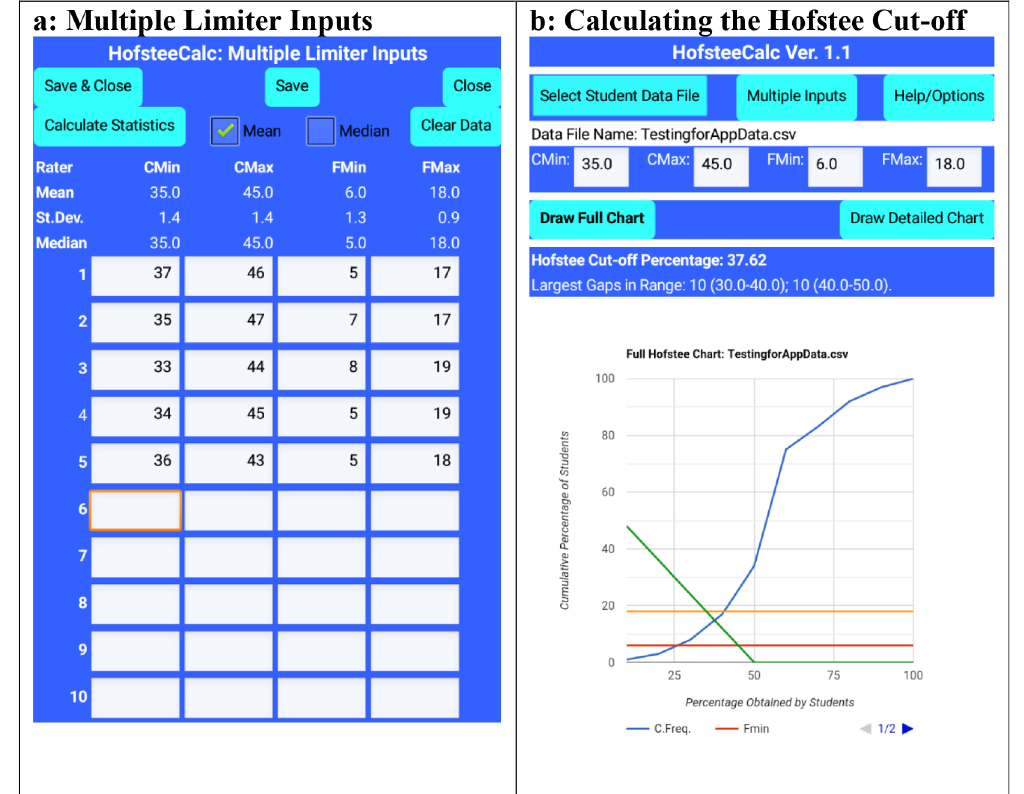
Figure3.HofsteeCalcapp:multiplejudges ’ parametersandoutputfromFigure1data,wherec min isminimum cut-off score, c max is maximum cut-off score, f min is the lowest percentage of students that the judge feels should fail, and f max is the highest percentage of students that the judge feels should